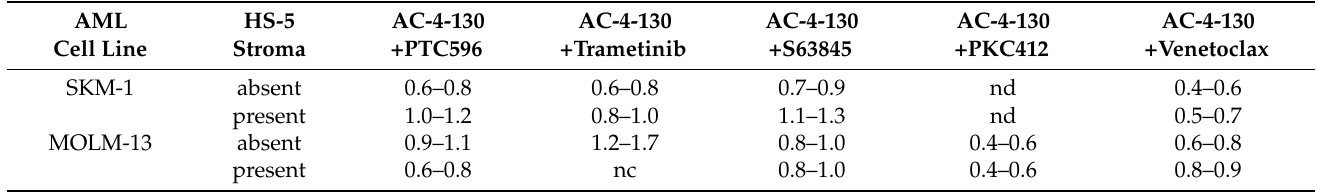
Figure 3. Susceptibility of SKM-1 and MOLM-13 AML cells to various treatment combinations. Cell viability was determined by AML cells grown in the absence ( A , B ) and in the presence ( C , D ) of HS-5 stroma cells. SKM-1 ( A , C ) and MOLM-13 ( B , D ) cells were treated for 20 hours with single compounds and in combination with AC-4-130 (AC, yellow) and PTC596 (P, red), S63845 (S, blue), or trametinib (T, pink). Concentrations of inhibitors are nM for PTC596, S63845, and trametinib, and µ M for AC-4-130. All values are in reference to mock-treated cells (=100% viability). Table 2. Combination index values in AML cell